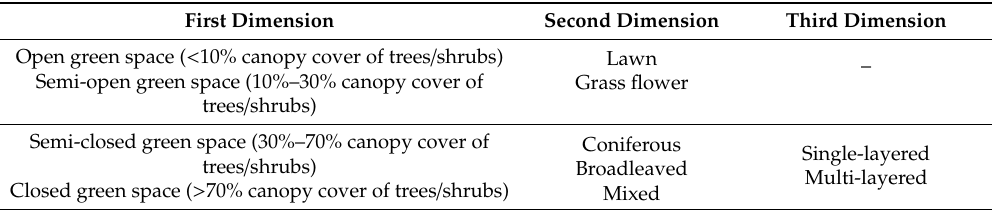
Table 1. Classification with three dimensions of urban forest in Beijing. First Dimension